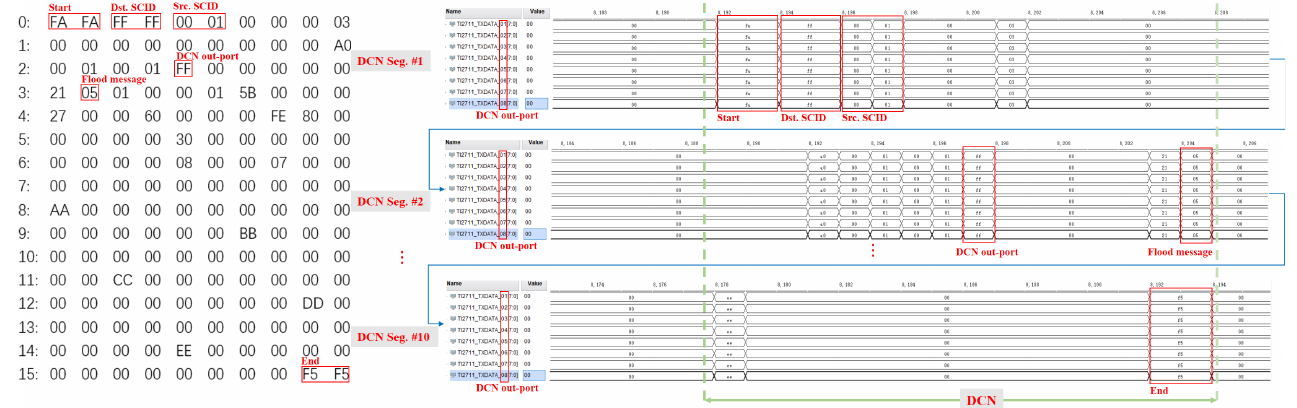
Figure 18. A data communication network sequence diagram for a management and controlling flooding message, i.e., satellite link plan of connections , from node vx_simulator_01 (SCID 1) to other